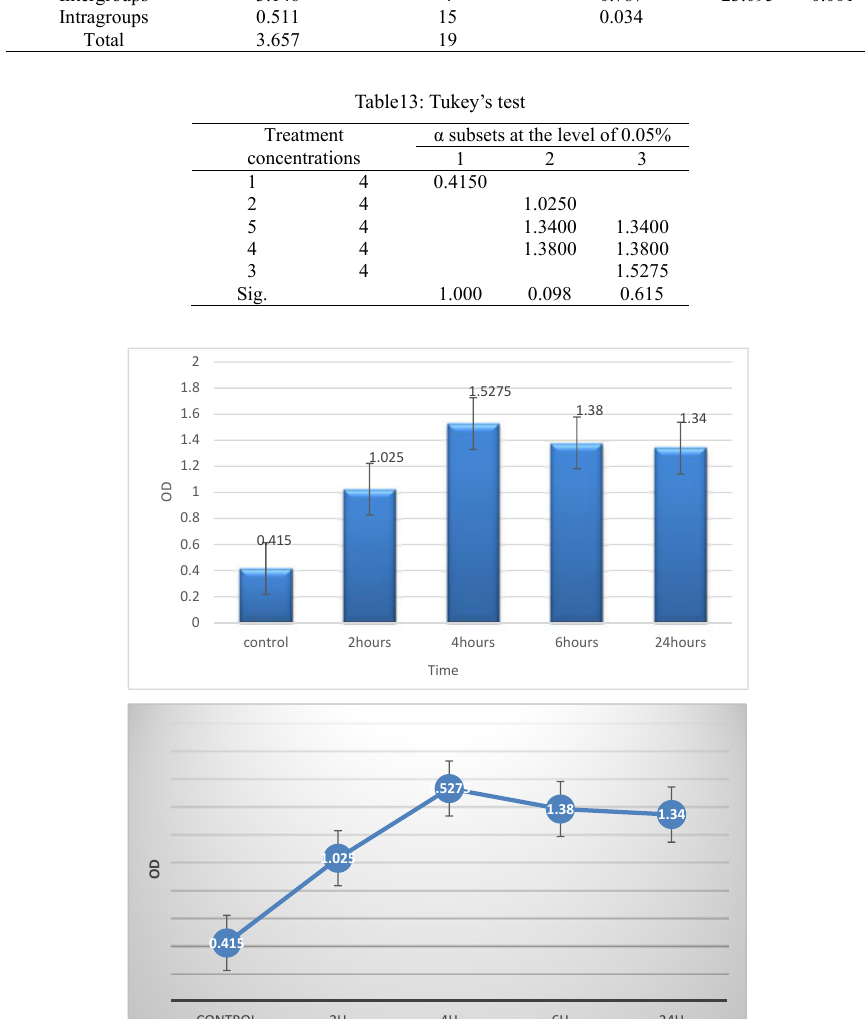
Table12: Analysis of variance of OD at different antibacterial concentrations of copper oxide nanoparticles